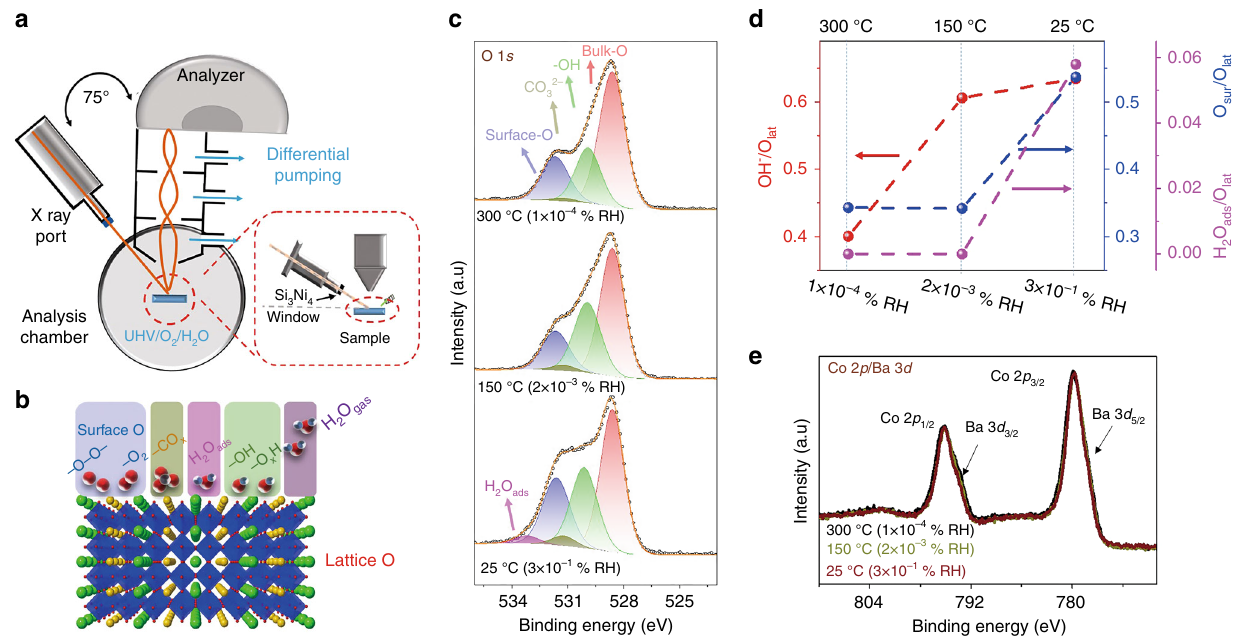
Fig. 5 Adsorption of water on PBSCF (100) measured by APXPS. a Schematic of the APXPS. b Schematic illustration of the multilayer O model. c O 1s XPS spectra. d Comparison of fi tting results for HO − /O lat , O sur /O lat and H 2 O ads /O lat ratio. e Co 2p/Ba 3d XPS spectra on the (100) fi lm in 1 mbar H 2 O